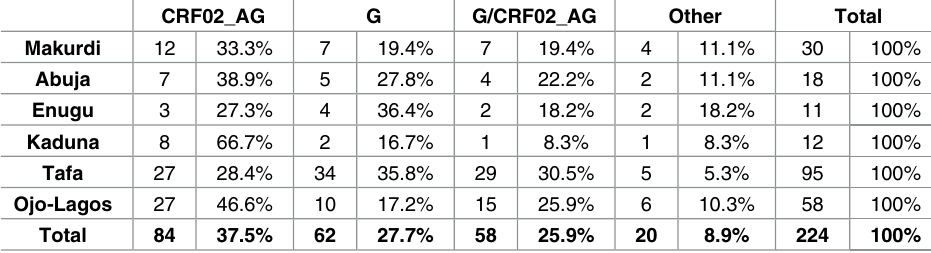
Table 1. Distribution of major HIV-1 subtypes in the six study sites as analyzed by Multi-region Hybridization